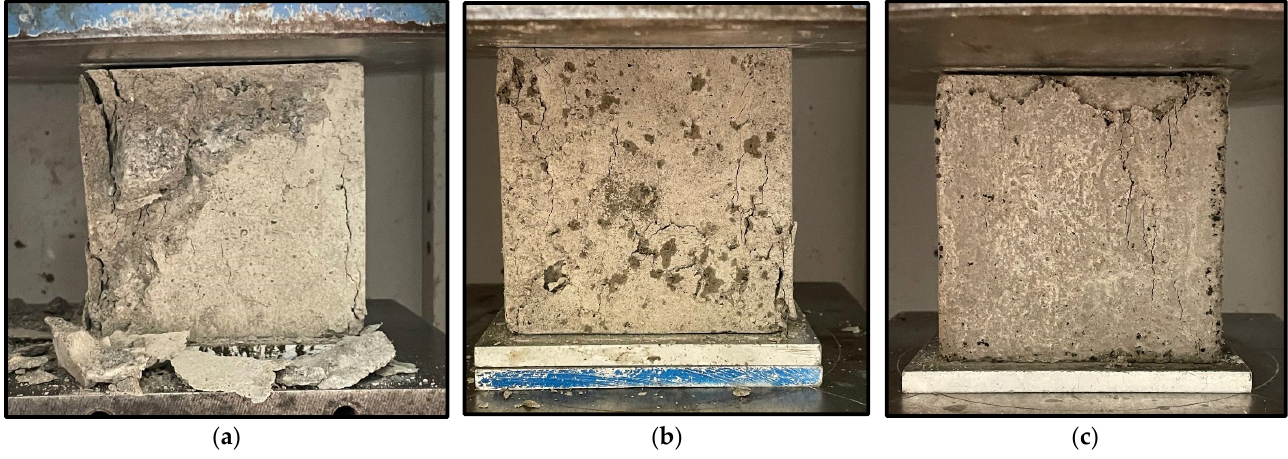
Figure 6. Failure mode of NaOH-CRC. ( a ) Control (M1-0%NaOH, 0%CR). ( b ) M3 (0%NaOH, 10%CR). ( c ) M6(10%NaOH,